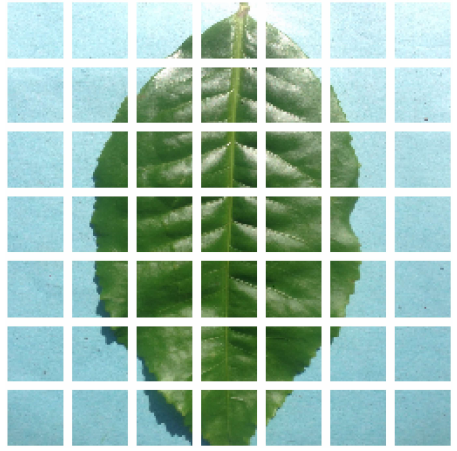
Figure 1. Grid description of size 7.